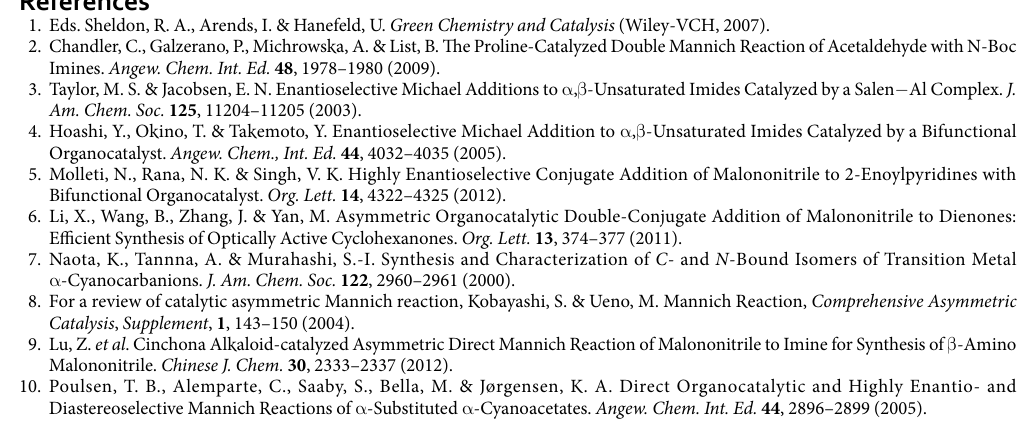
N -Boc imine. By flipping the face of the N -Boc imine, as shown in Model B, the steric repulsion can be released, and nucleophilic attack of the Re -face of the N -Boc imine gives the ( R )-enriched Mannich product. In conclusion, the dinuclear bis(phosphoimino)binaphthoxy-Pd 2 (OAc) 2 complex described herein facilitated a double Mannich reaction of N -Boc-imine with malononitrile to give chiral 1,3-diamines in a highly enantiose- lective manner. This demonstrates that over-reaction need not always be useless and undesired: well managed over-reaction can open up novel synthetic processes.